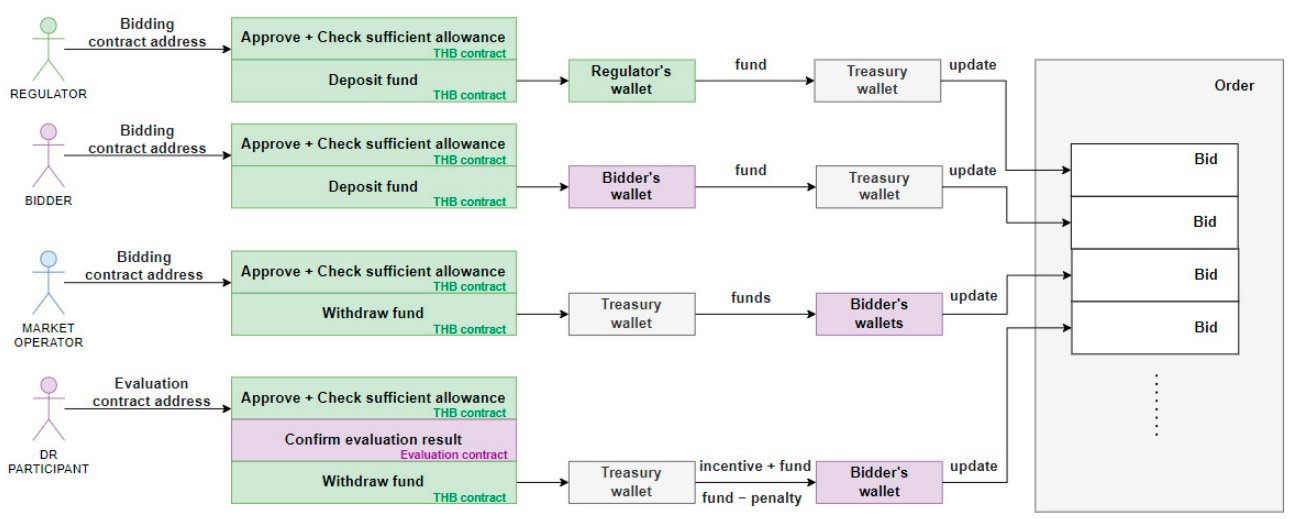
Figure 5. Guaranteed fund